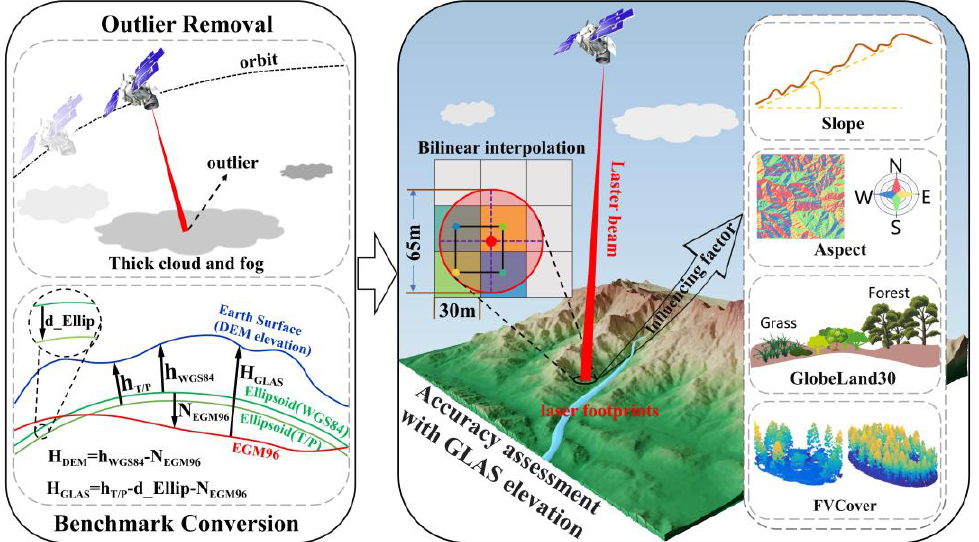
Figure 2. Schematic of DEMs comparison with ICESat/GLAS data.